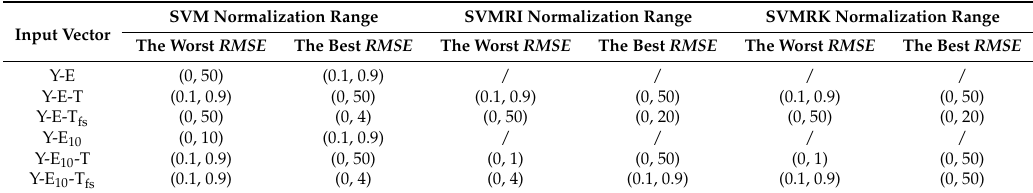
Table 4. Support vector machine normalization range.